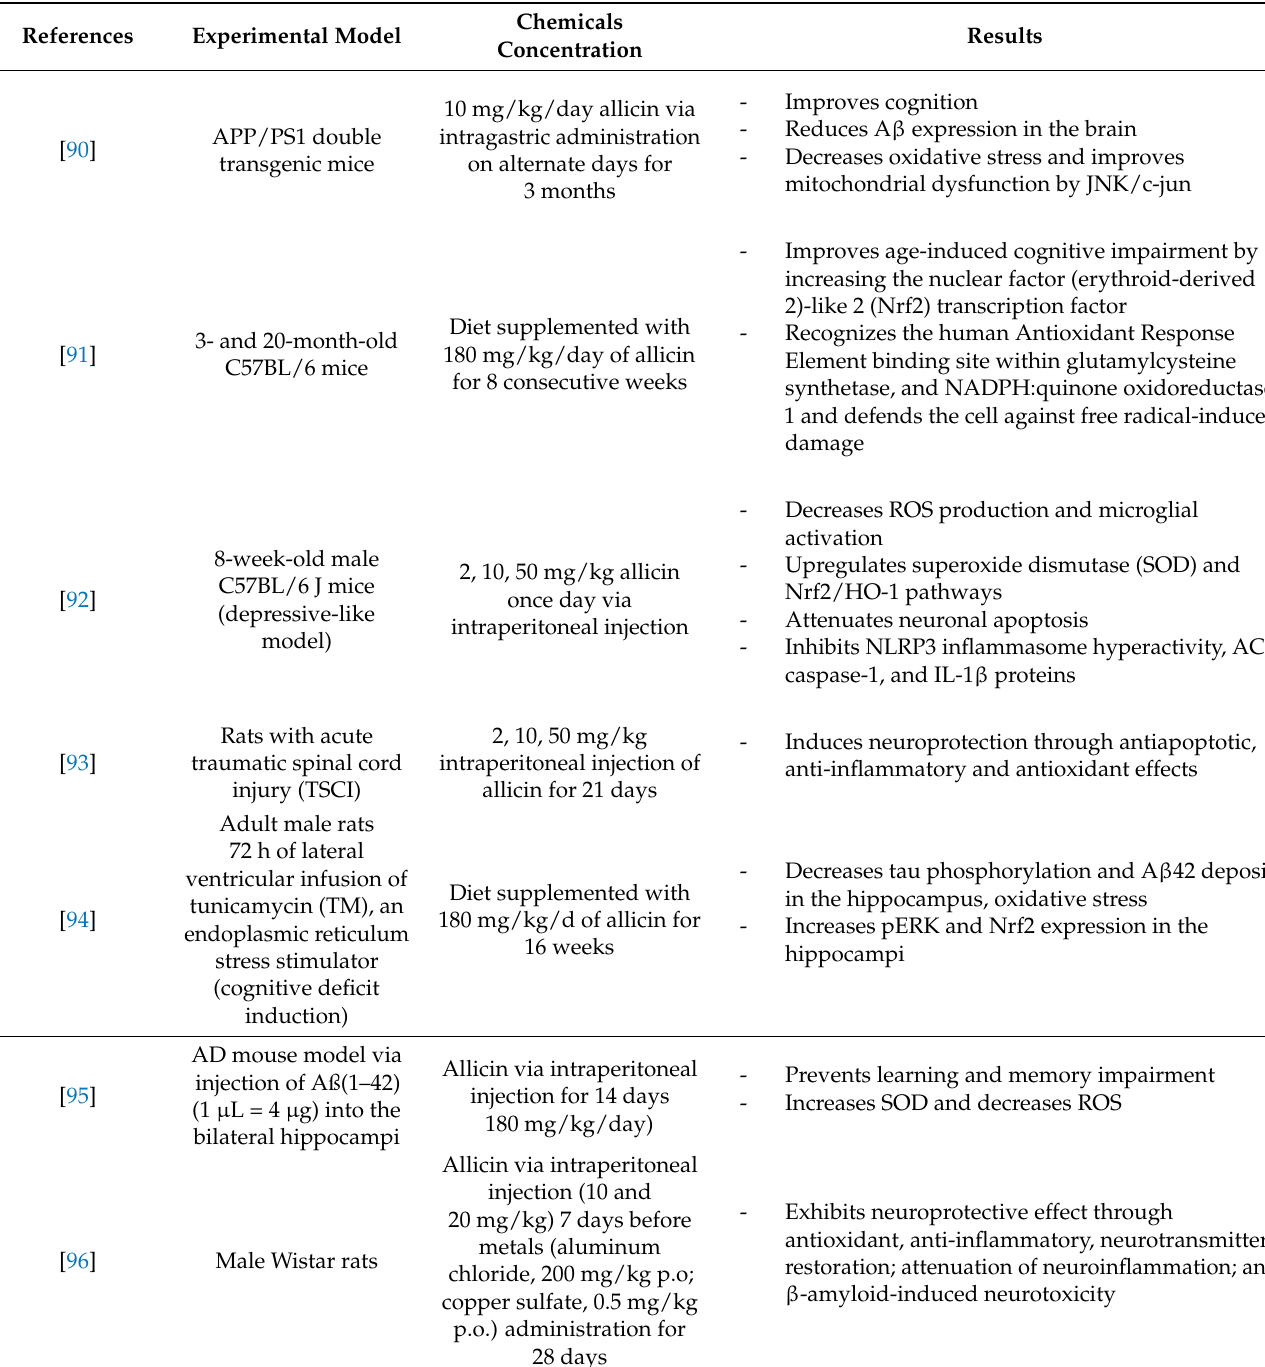
Table 1. Summary of experimental details, including model, chemical concentration and main results of in vitro and in vivo studies of allicin and AD